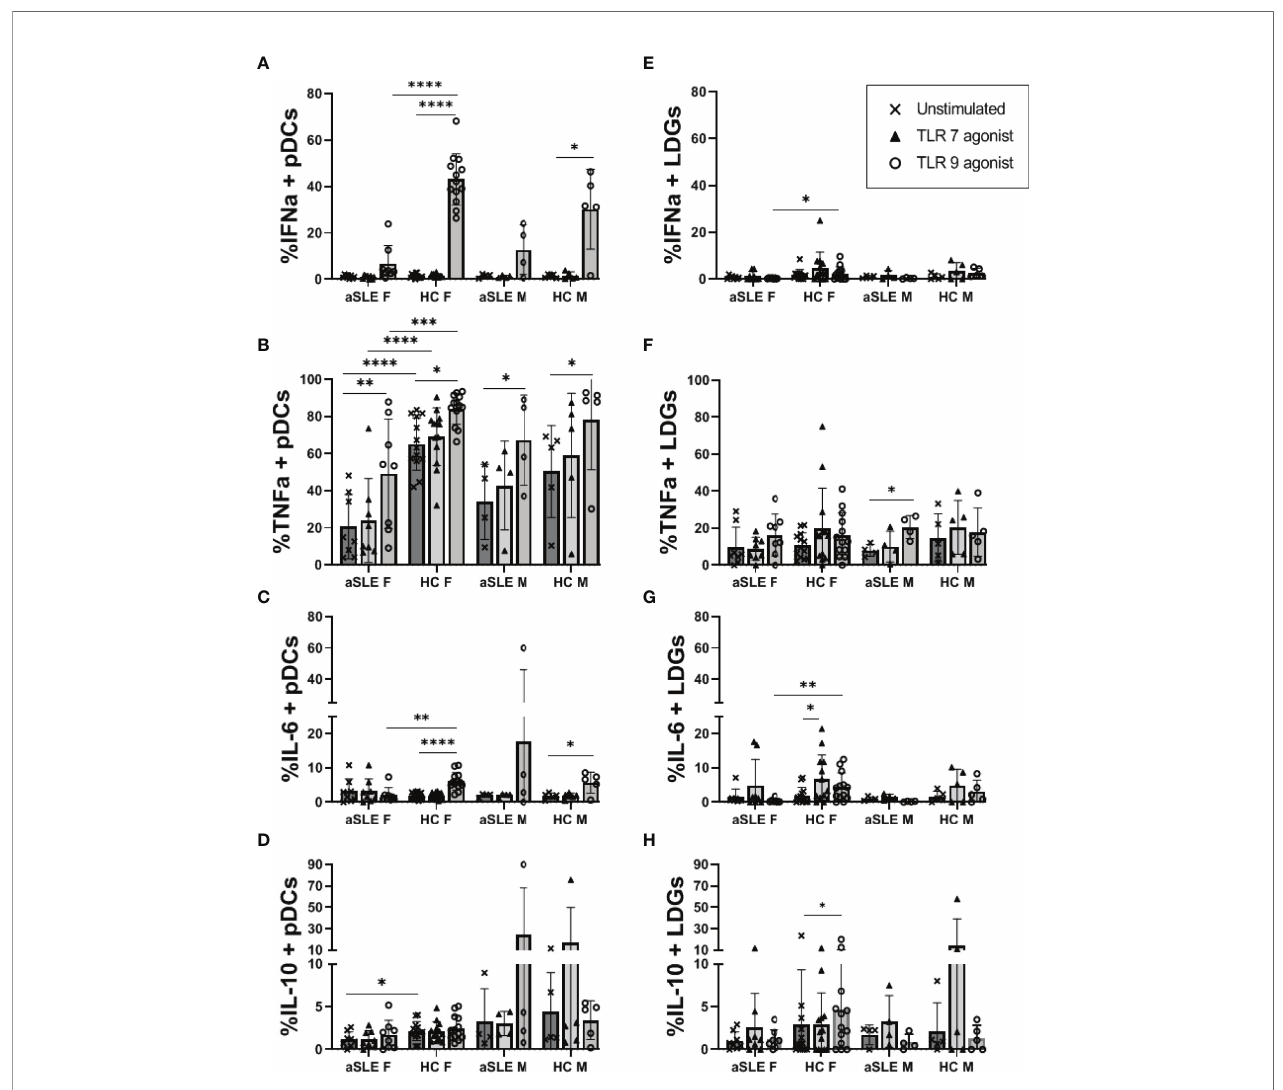
FIGURE 6 | TLR mediated production of IFN a and TNF a is decreased in patients with SLE. PBMCs from a subset of healthy controls and patients with active SLE disease were cultured in the absence or presence of TLR7 agonist (ORN R2336) or TLR9 agonist (ODN2216) for 6 hours. Cells were then fi xed and stained for intracellular levels of IFN a , TNF a , IL-6, and IL-10 in pDCs (A – D) and LDGs (E – H) . Comparisons were made by ANOVA with Fisher test for multiple comparisons. Bars represent mean and SD. aSLE F (N = 8), HC F (N = 13), aSLE M (N = 4), and HC M (N = 5). *p < 0.05; **p < 0.01; ***p < 0.001; ****p <